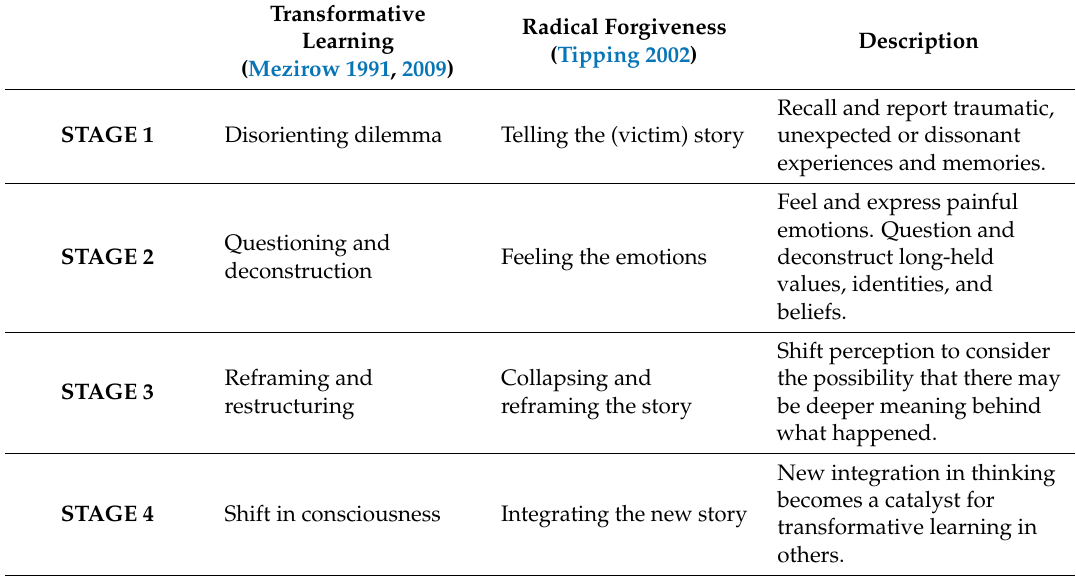
Table 1. Psychosocial models for transformative